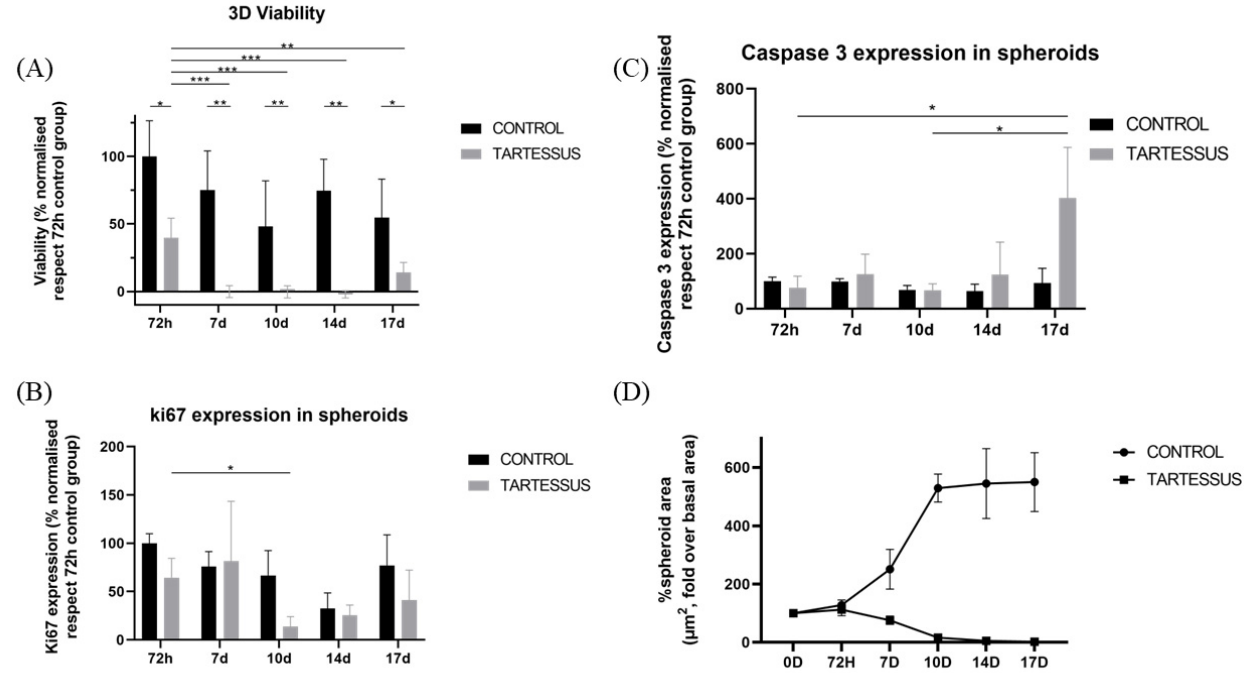
Figure 5. Experimental results obtained from 3D cultures: ( A ) cell viability, ( B ) cell proliferation measured using Ki-67 activity, ( C ) cell death determined by caspase 3 levels, ( D ) spheroid size. Results are shown normalized with respect to the 72 h control group, except for the spheroid size, which is shown normalized with respect to the size at the start of the treatment. Significant differences (*), very significant differences (**), and extremely significant differences